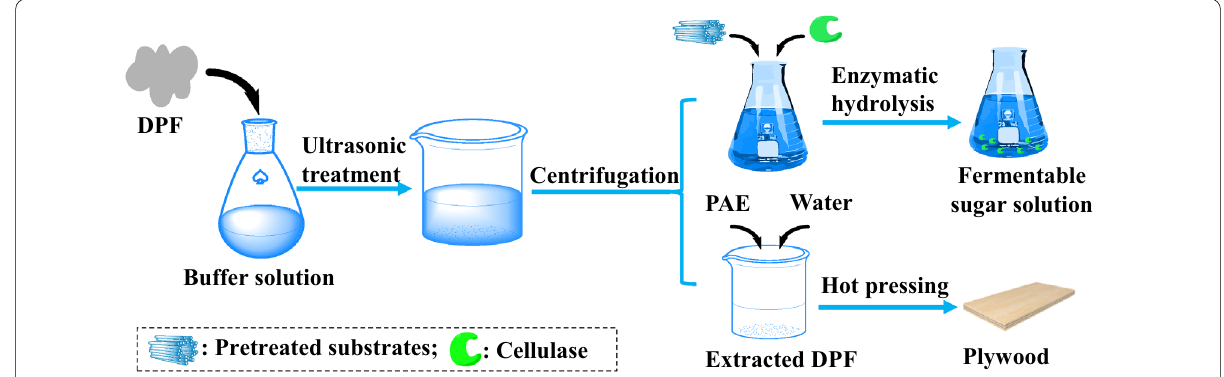
Fig. 1 Schematic diagram of using DPF to prepare lignin-blocking additive and